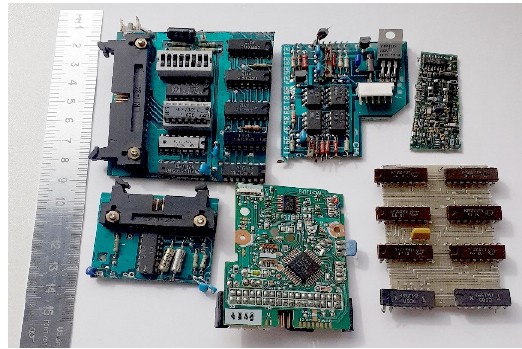
Figure 3. Image of computer PCBs used for the study.